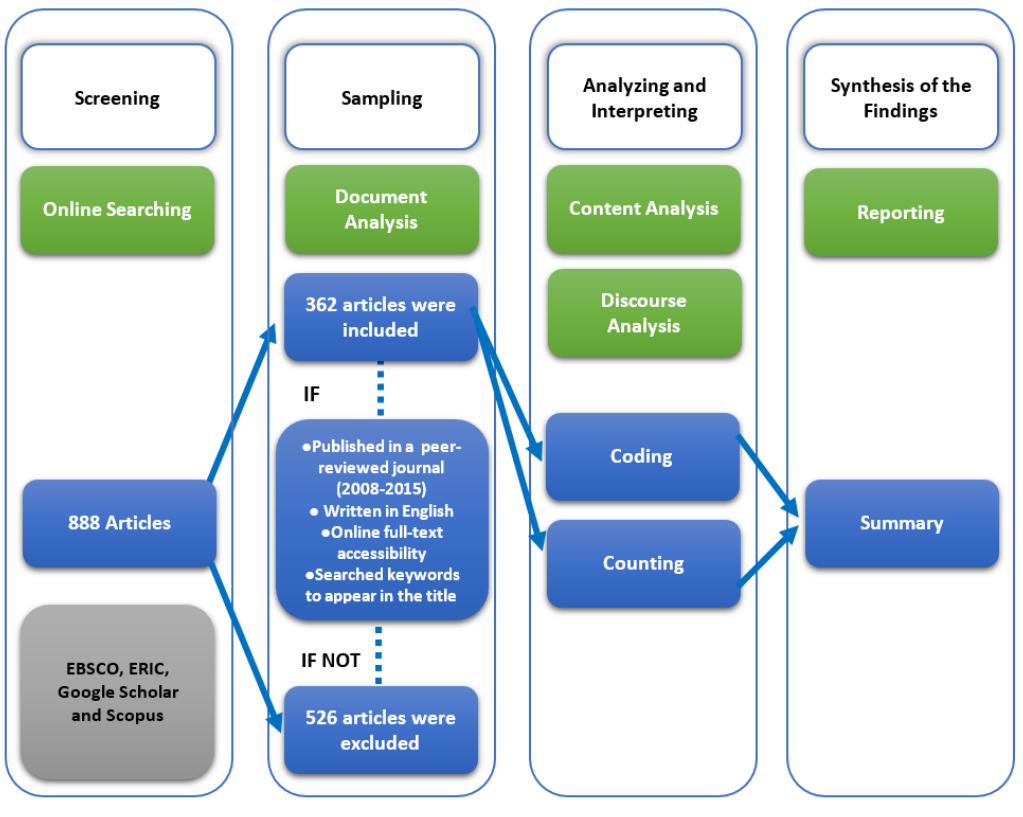
Figure 2 . The overall research